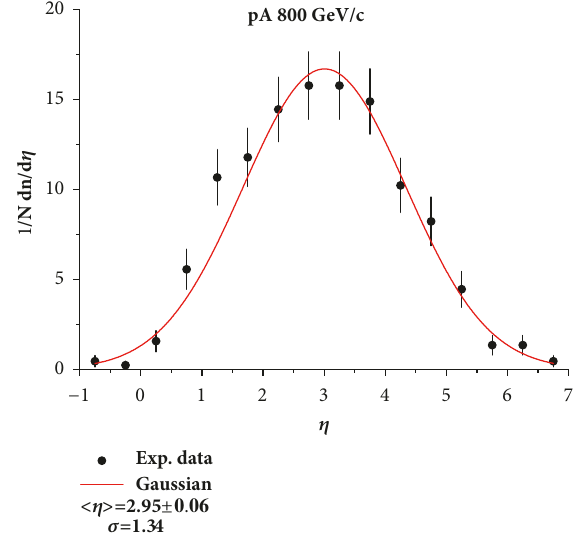
Figure 2: Pseudorapidity distributions of shower particles in selected proton-nucleuscollisions. Curve is a Gaussian